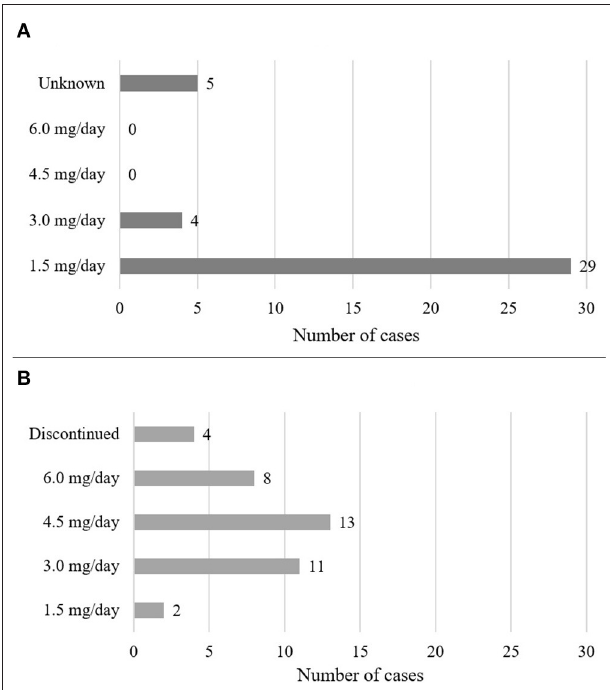
FIGURE 3 | Dosing of cariprazine. The figure shows the starting (A) and maintenance (B) doses of